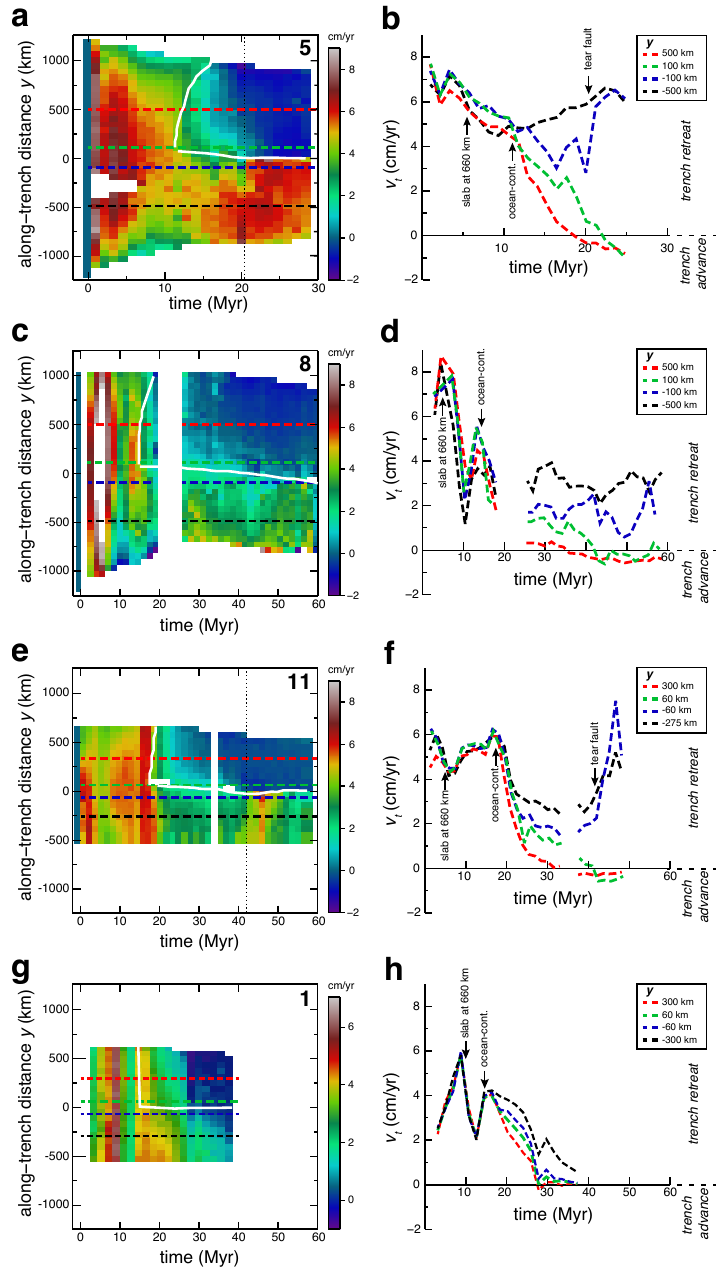
Fig. 3. (a) Trench migration rate as a function of time along y-axis for model 5, i.e. a large subduction zone with a vertical tear fault developing after 20.5Myr of subduction (black dotted line). Zero on the y-axis corresponds to the location of the discontinuity between oceanic and continental lithospheres. Positive and negative values indicate oceanward and continentward trench motions, respectively. A solid white line underlines the onset of continental lithosphere subduction. (b) Trench migration rate as a function of time for sections located 500km (red line) and 100km (green line) north of the discontinuity and 100km (blue line) and 500km (black line) south of it (see location on Fig. 3a). Slab reaches the upper-lower mantle discontinuity after 6Myr. Subduction of the positively-buoyant slab starts after 11Myr. (c) Same as (a) but for a large subduction zone without a vertical tear fault (model 8). The area in white corresponds to a period of no data acquisition. (d) Same as (b) but for model 8. (e) Same as (a) for a narrow subduction zone with a vertical tear fault developing after 42Myr (model 11). (f) Same as (b) but for model 11 and sections located 300km (red line) and 60km (green line) north of the discontinuity and 60km (blue line) and 275km (black line) south of it (see location on Fig. 3e). (g) Same as (a) for a narrow subduction zone with an overriding plate (model 1). (h) Same as (b) but for model